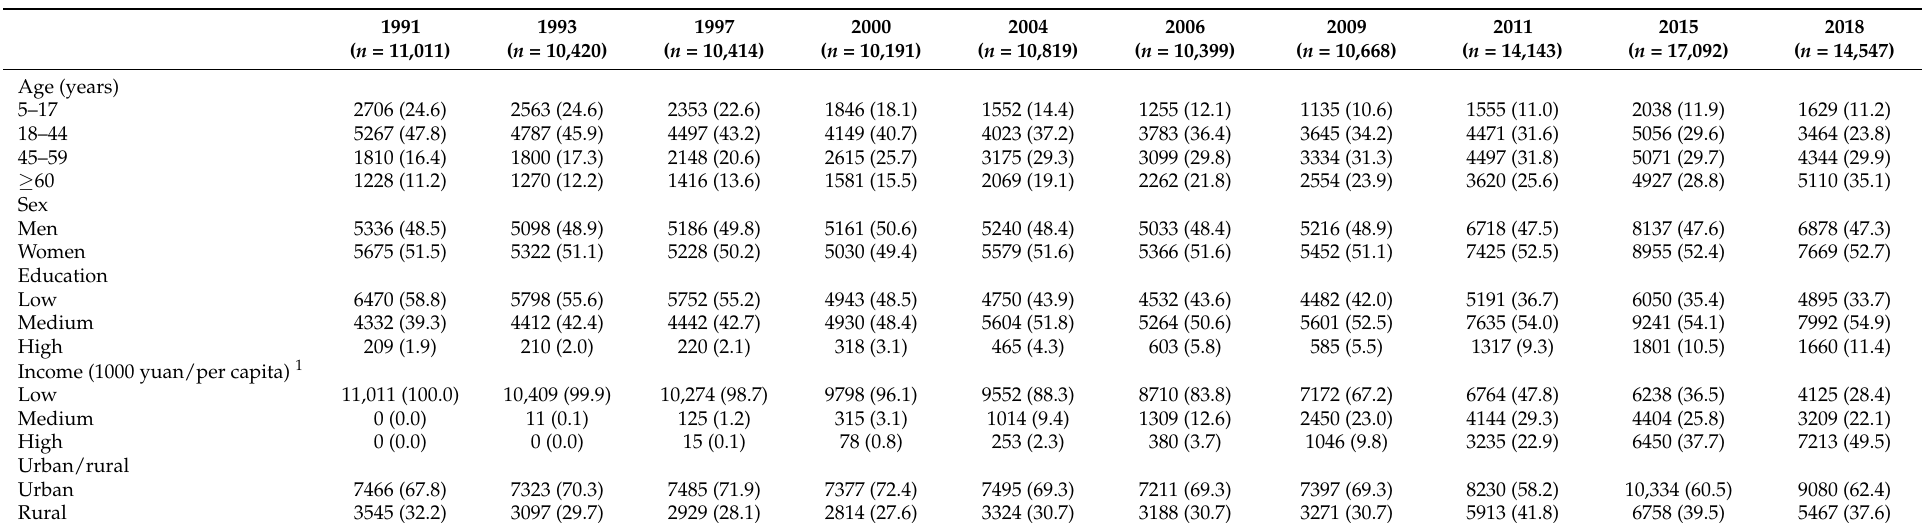
Table 1. Characteristics of Chinese residents aged over 5 years by CHNS,